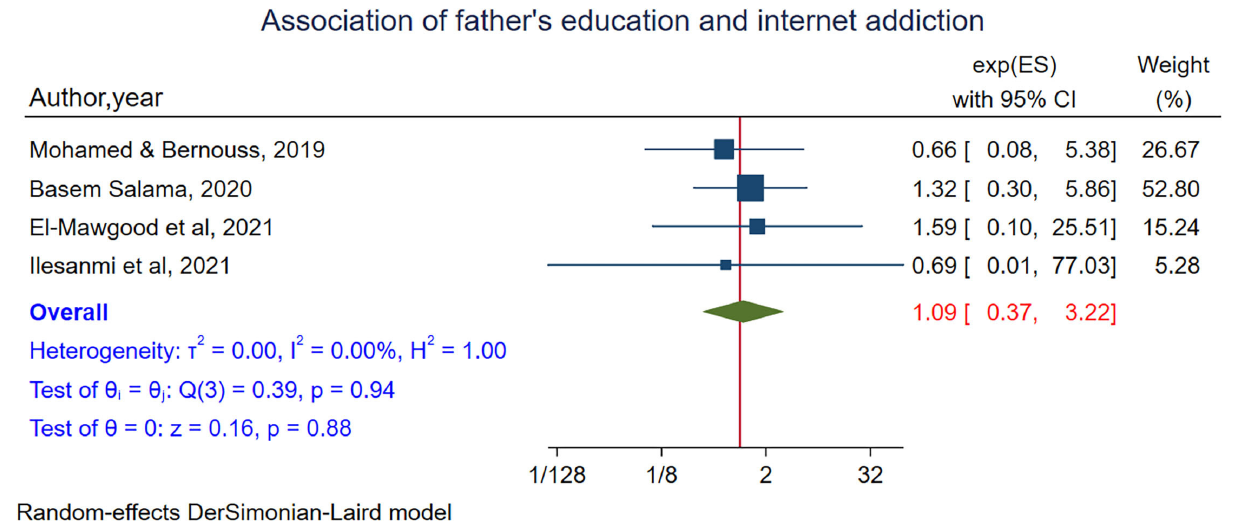
2014; Doornwaard et al., 2016; Islam and Hossin, 2016). Which can increase addictive behaviors in male